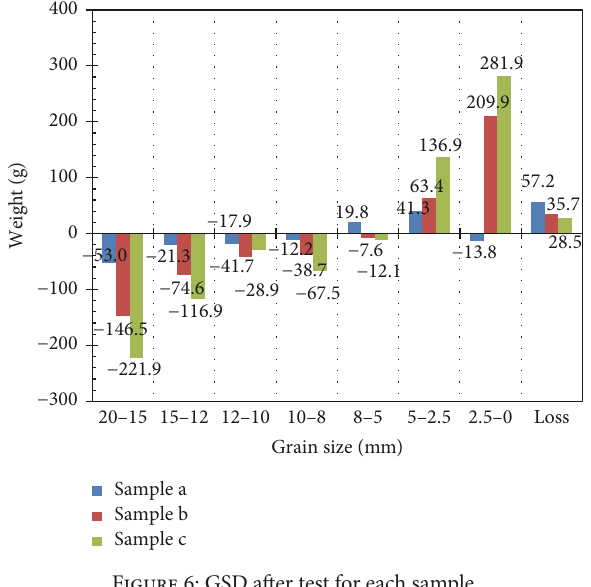
Figure 6: GSD after test for each sample.